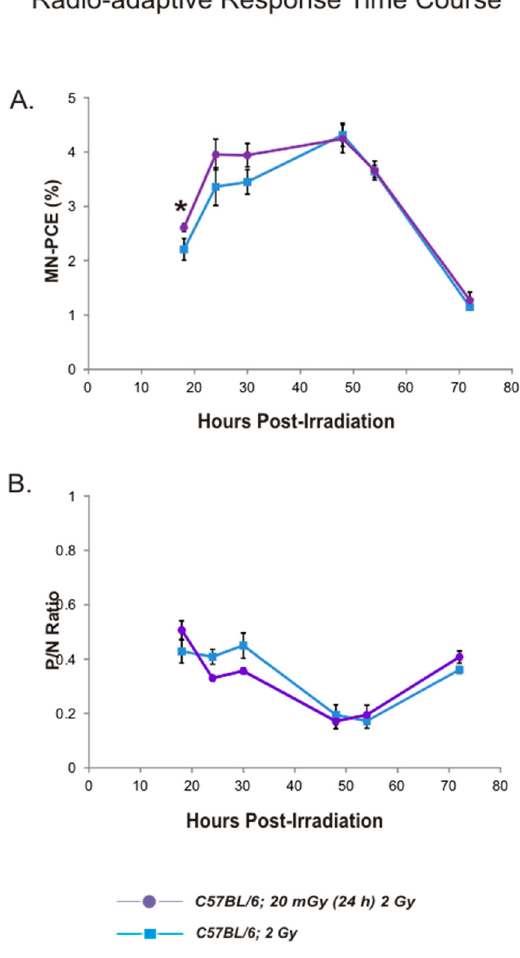
Figure 5. Radio-adaptive response time course analysis of MN-PCE frequencies and P / N ratios in mouse bone marrow. MN-PCE frequencies ( A ) and P / N ratios ( B ) following in vivo 20 mGy priming and 2 Gy challenge irradiations (purple circle symbols) or 2 Gy irradiation only blue (square symbols; data reproduced from Figure 3). Data points represent the mean value of pooled samples; error bars indicate standard error. Six animals were sampled per treatment group, with the exception of the 24 h time point, comprised of 18 animals for MN-PCE analysis (reproduced from Figure 2), 15 animals for P / N ratio determination (reproduced from Figure 2) and seven animals for the 2 Gy dose preceded by the 20 mGy priming dose treatment. * p < 0.05 for unpaired Student’s t -test.